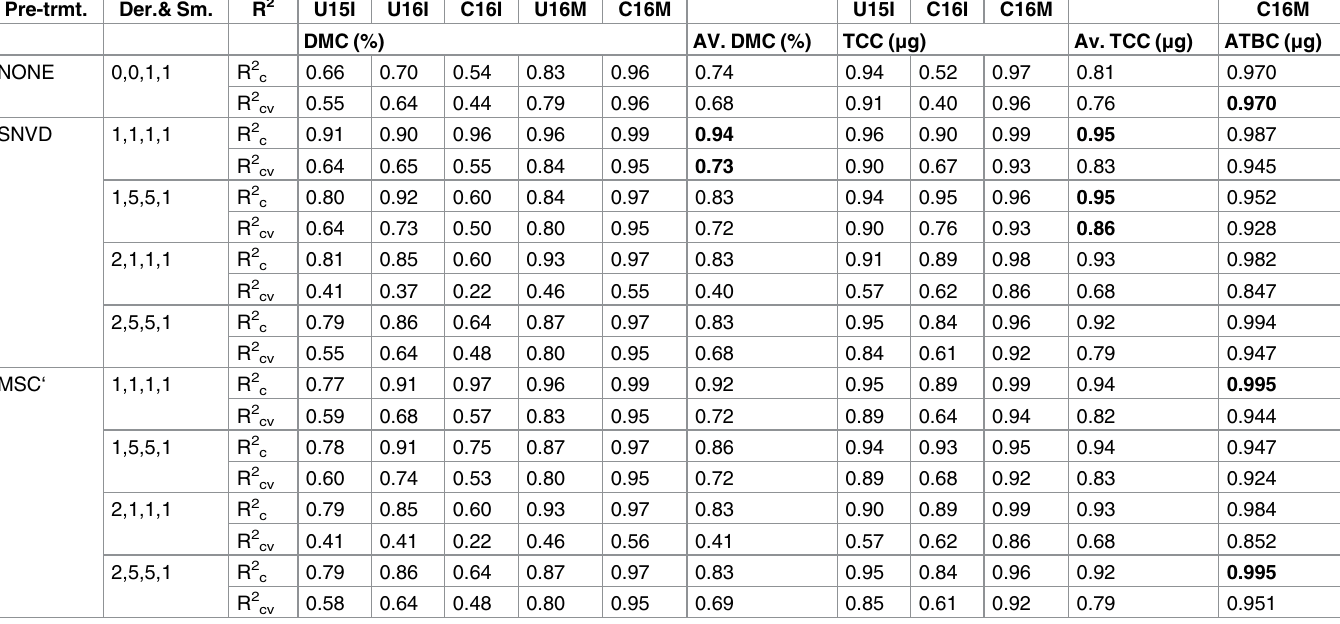
Table 3. The effect of mathematical pre-treatments on models from different calibration sets.